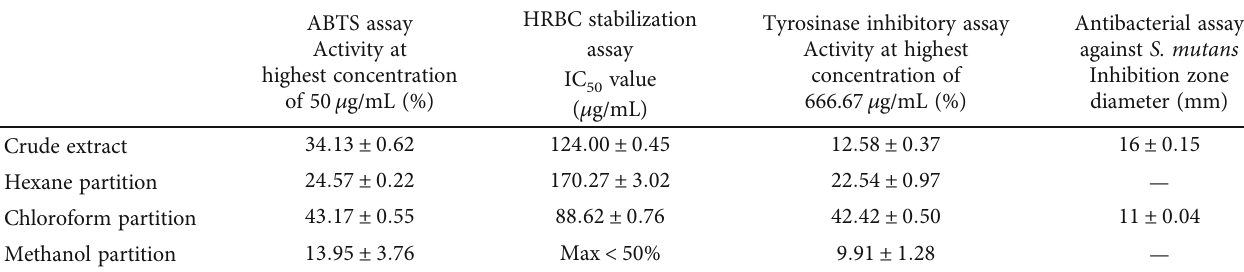
Table 1: Summary of bioactivities of crude extracts and partitions of Phanerochaete sordida.